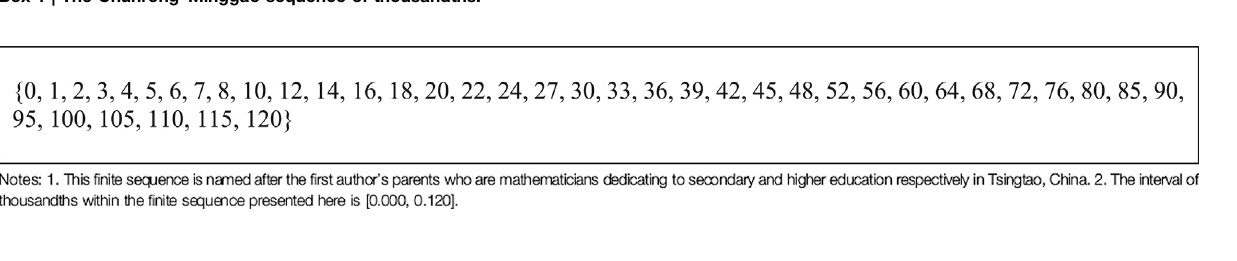
TABLE 9 | Sequences of thousandths to determine unavailability upon megaproject sustainability. Sequence of optimistic Sequence of pessimistic Sequence of the most likely unavailability ( ‰ ) Expected unavailability ( ‰ ) unavailability ( ‰ ) unavailability ( ‰ )